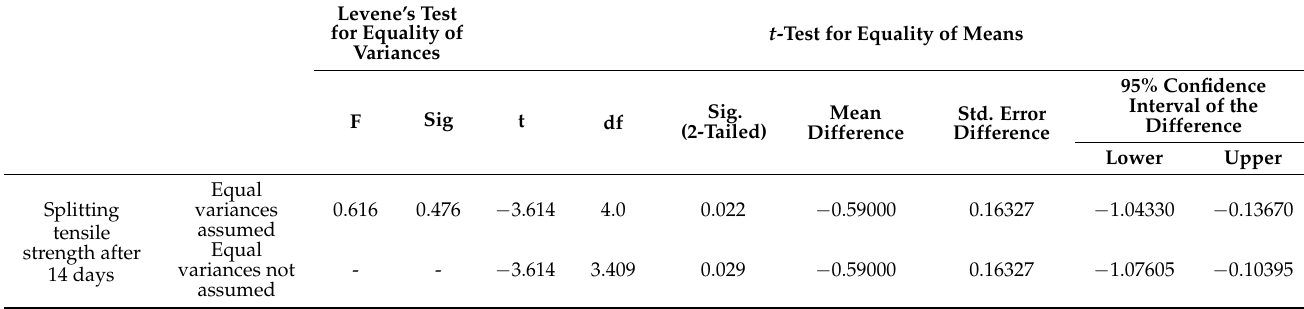
Table 15. Independent t -test for splitting tensile strength after 14 days.